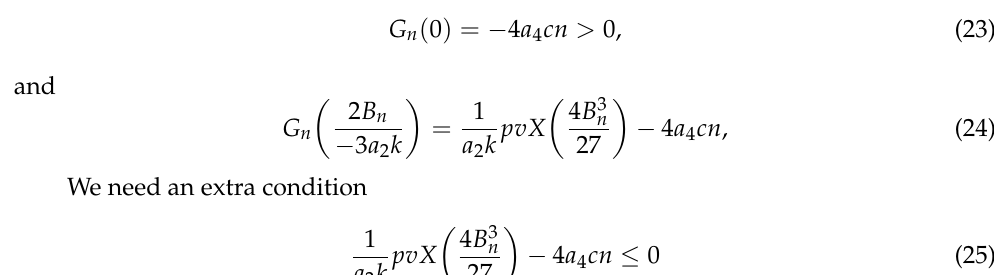
Figure 1. Graph of G 𝑛 (𝑦) for Cases I and II. Based on Equation (20), and